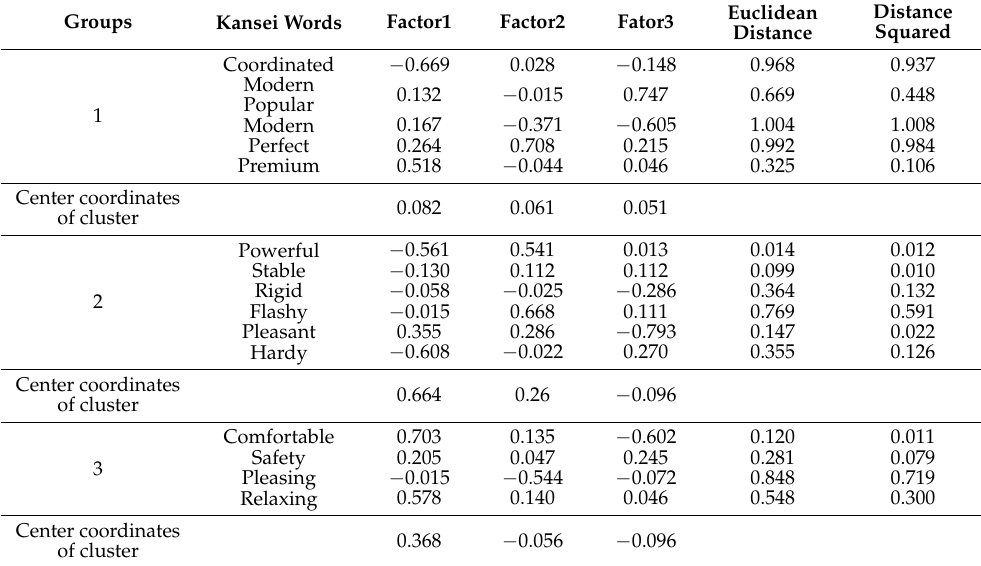
Table 1. Results of factor analysis and shortest Euclidean distance method for three Kansei